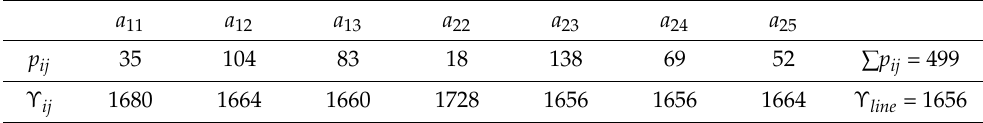
Table 5. Final ALB solution proposed by this study.